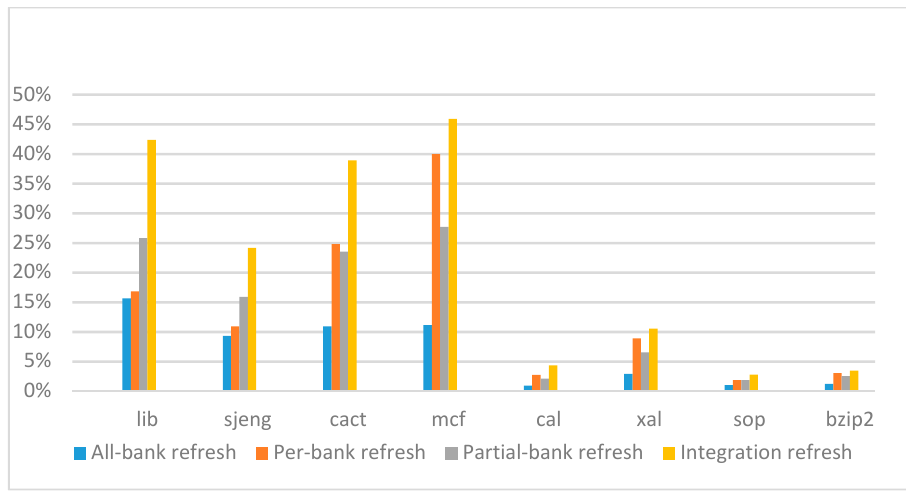
Figure 21. IPC improvement normalized to 1x granularity baseline (tRFC = 890 ns, weak row = 5%). From the experimental results on different refresh cycle times, we see that as DRAM size increased, the 2x granularity integration refresh scheme has an even more significant effect on the performance improvement, especially for memory-bound applications. Comparing these four 2x